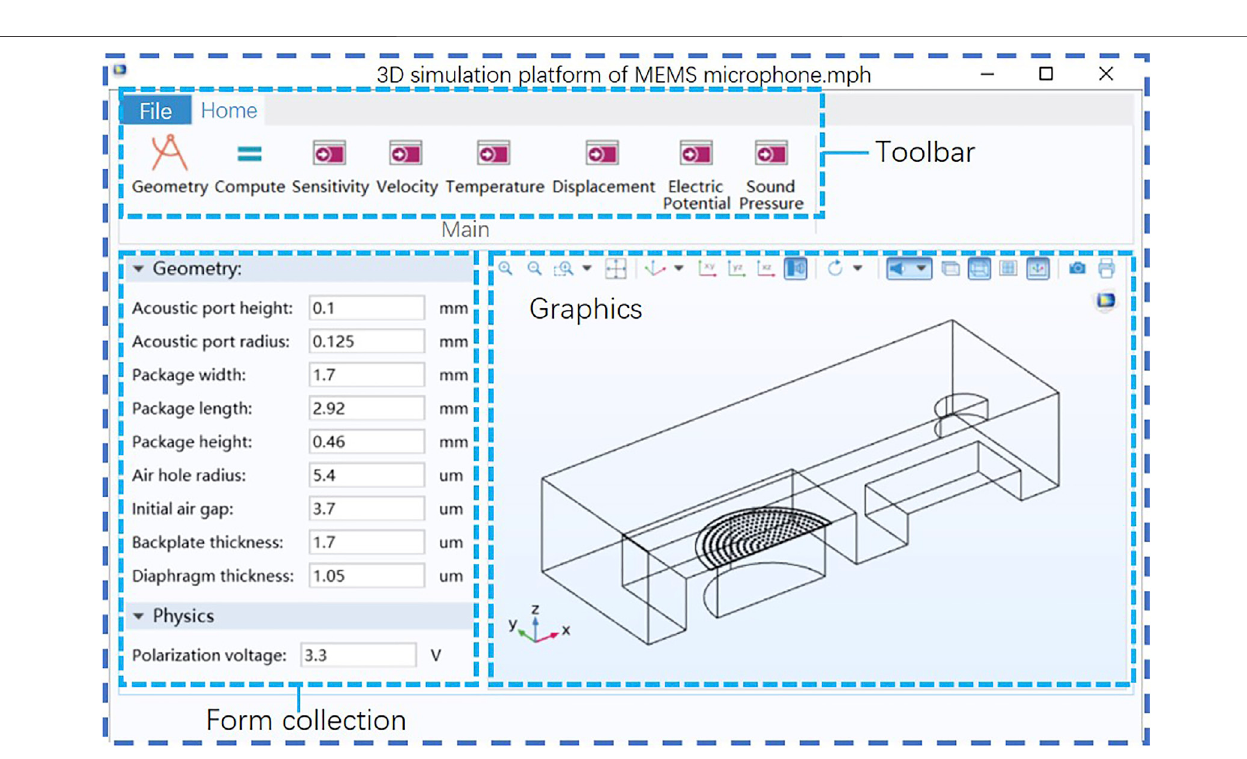
Frontiers in Materials |